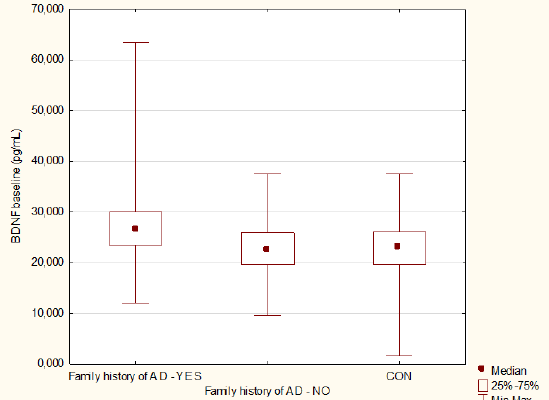
Figure 2. Brain-derived neurotrophic factor (BDNF) levels with regard to family history of affective disorders. Family history of affective disorders: YES vs . No p = 0.009. AD—Affective Disorders; disorders. Family history of affective disorders: YES vs. No p = 0.009. AD—Affective Disorders; CON—Healthy Controls. CON—Healthy